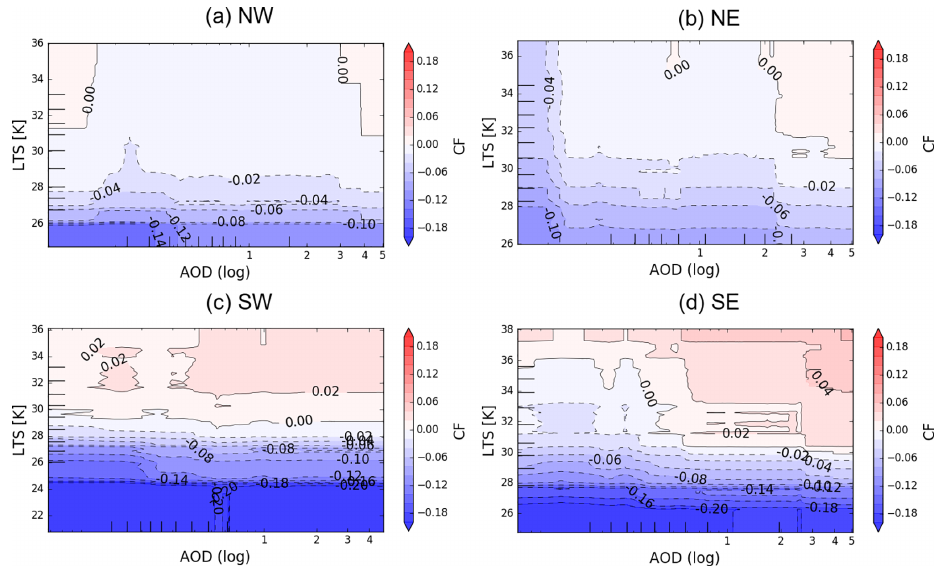
Figure 8. Two-variable partial dependence of CF on LTS and AOD in the four subregions NW (a) , NE (b) , SW (c) and SE (d) during JAS. Description as in Fig. 5.